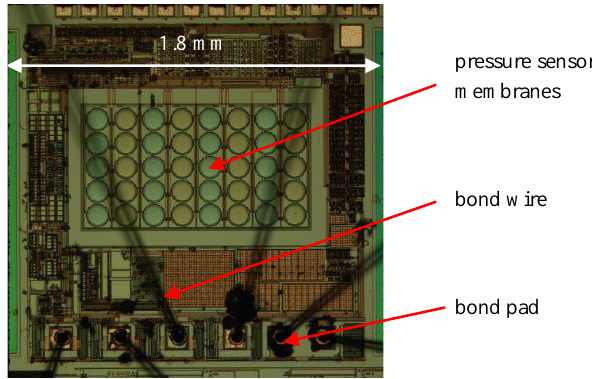
Figure 1. Photo of the pressure sensor chip after 1h in PBS at 150 ◦ C (Betz,